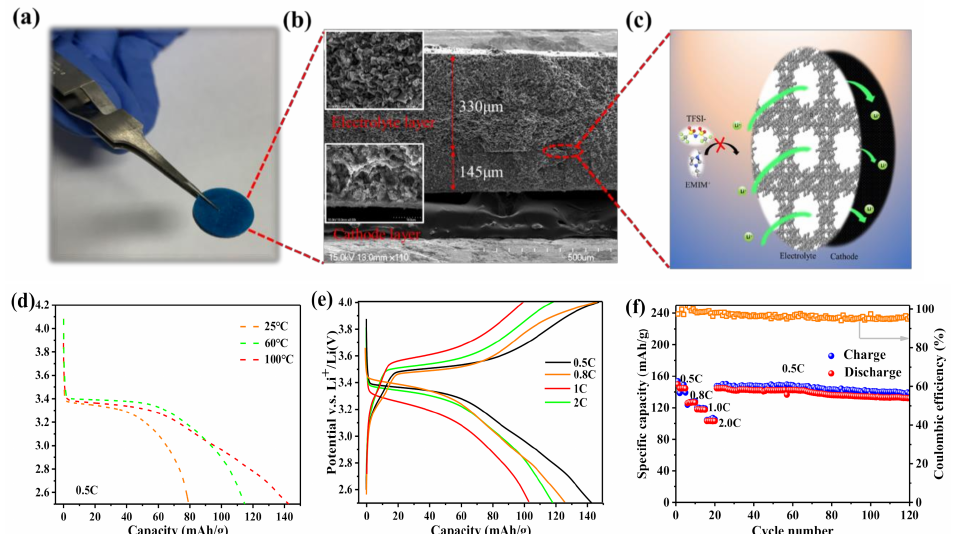
Figure 5. ( a ) Photograph and ( b ) cross-sectional SEM image of HKUST-1@IL-Li electrolyte/cathode bilayer pellet, and ( c ) schematic diagram of ion transport at the electrolyte–electrode interface. Electrochemical performance of a solid Li metal battery: ( d ) initial discharge curves at 25, 60 and 100 ◦ C; ( e ) galvanostatic charge–discharge plots from 0.5 C–2.0 C; and ( f ) cycle life performance at 0.5 C for the LiFePO 4 |HKUST-1@IL-Li|Li cell at 100 ◦